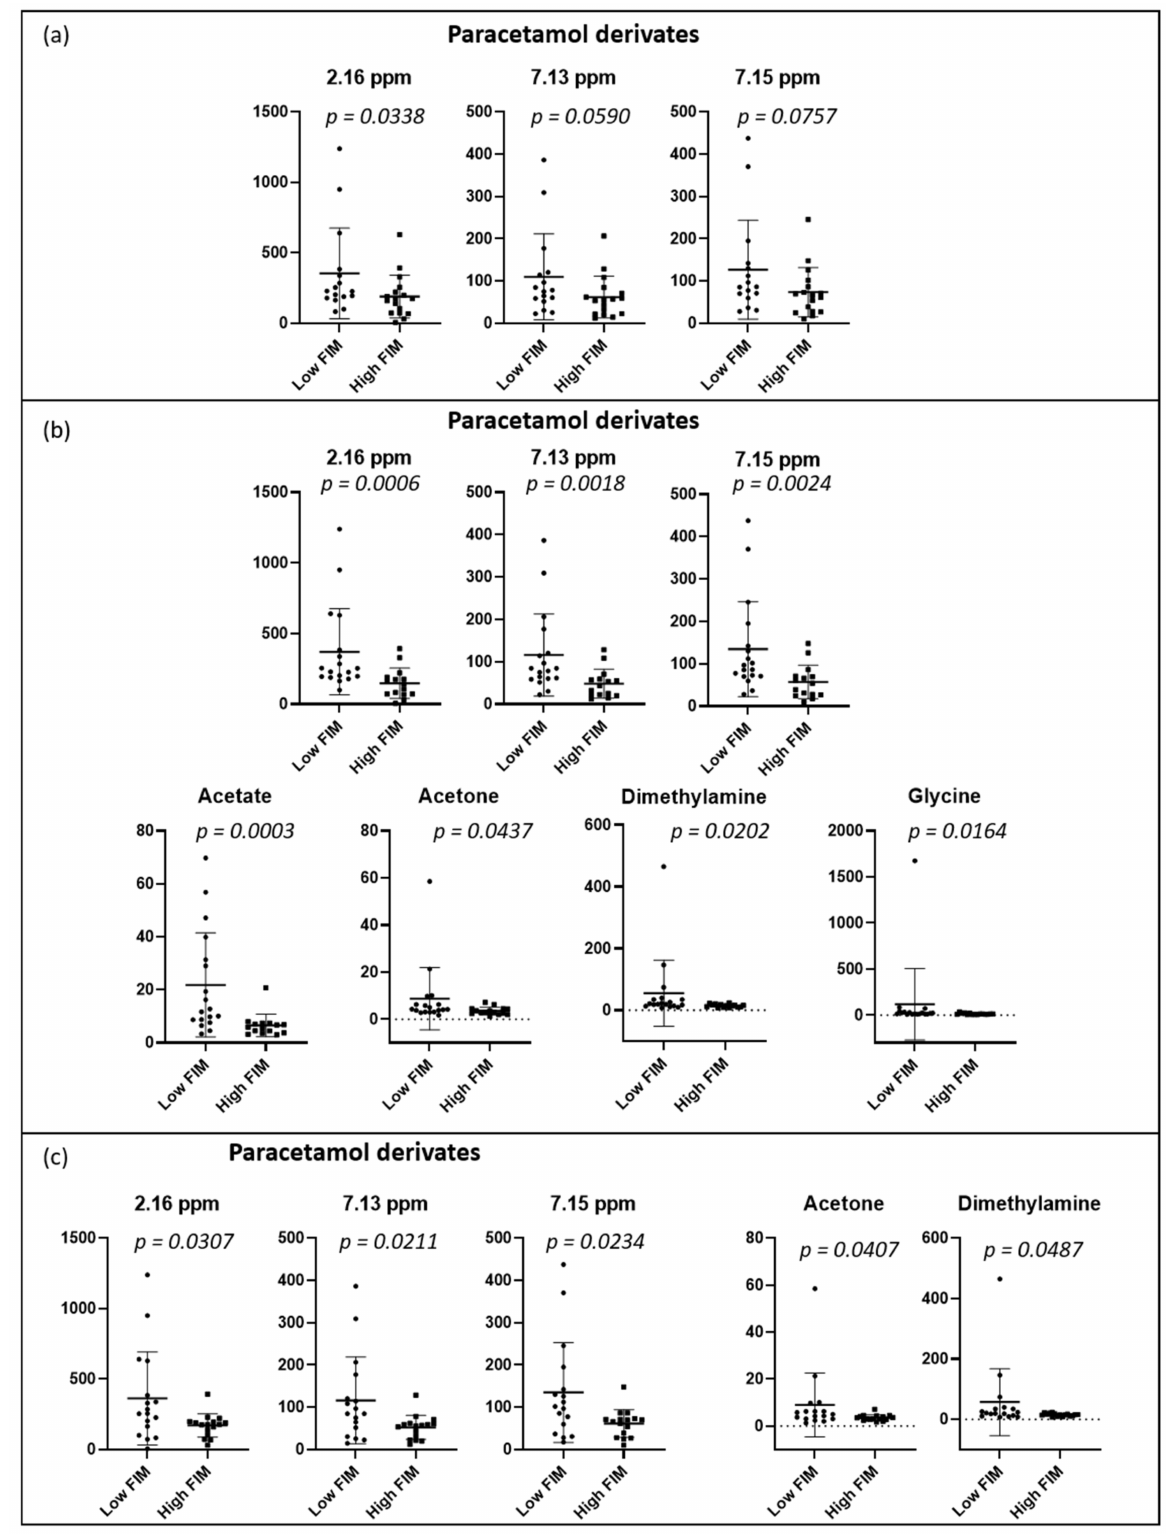
Figure 5. Dot plots of targeted metabolites showing significant differences between groups, ( a ) total FIM: low ≤ 102 (n = 16) and high >102 (n = 17); ( b ) motor component: low ≤ 74 (n = 18) and high >74 (n = 15), and ( c ) cognitive component: low ≤ 31 (n = 17) and high >31 (n = 16). FIM groups were dichotomized with medians. Plots represent mean ± stan- dard